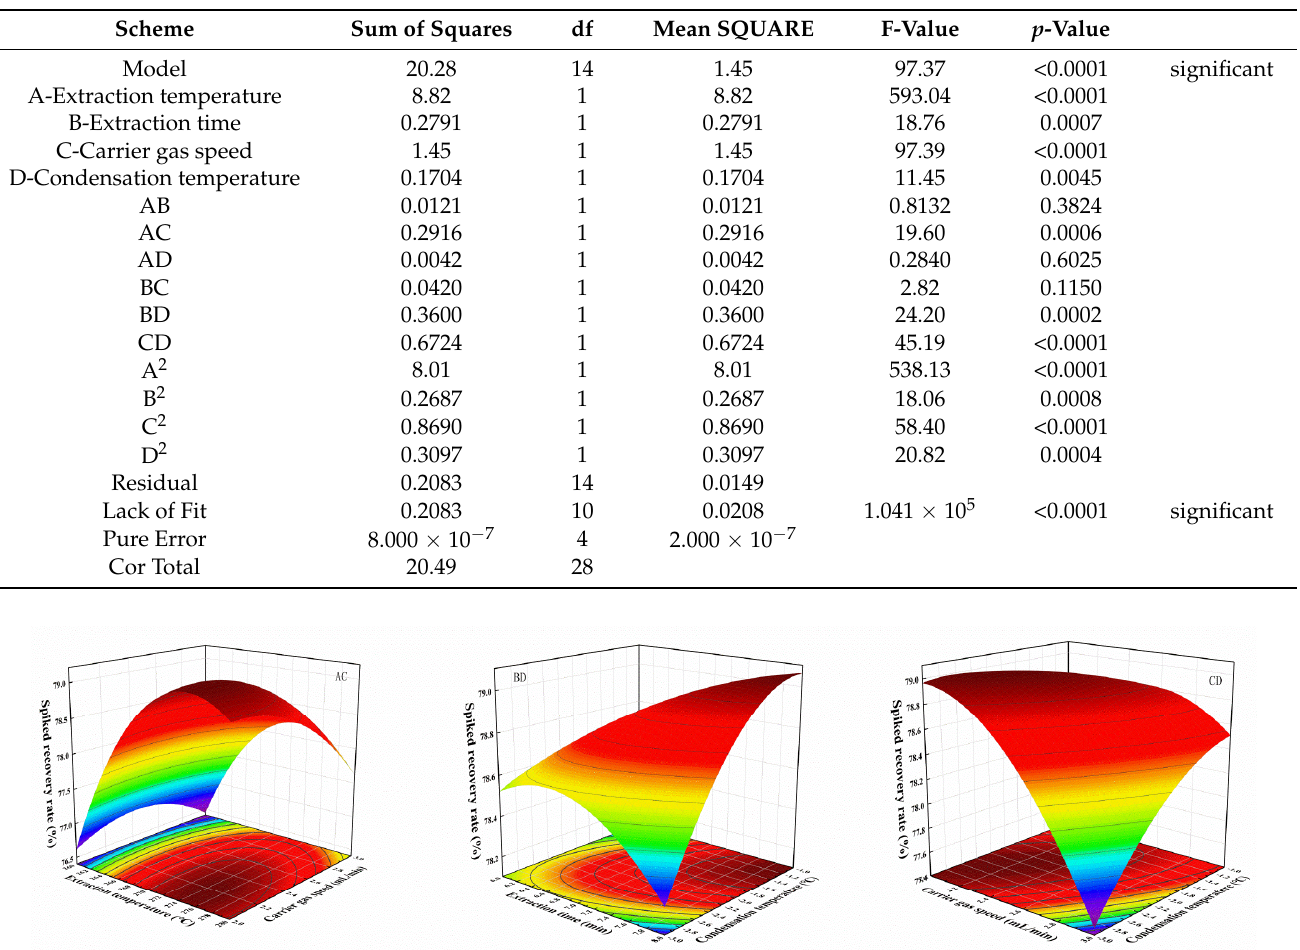
Table 1. Response to ANOVA for the spiked recovery rate of ethyl maltol samples.